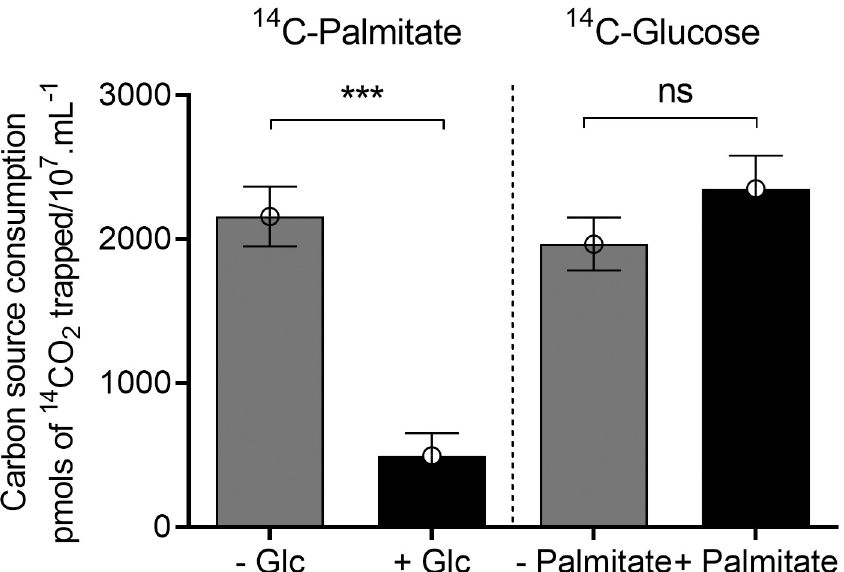
Fig 4. Glucose metabolism inhibits FAO. Parasites were incubated in the presence of 14 C-U-palmitate + 5 mM glucose and 14 C-U-glucose + 0.1 mM palmitate in PBS. 14 CO 2 production from epimastigotes incubated in PBS. The 14 CO 2 was captured after 120 min of incubation. The experiments were performed in triplicates. Statistical analysis was performed with one-way ANOVA followed by Tukey’s post-test p < 0.05 using the GraphPad Prism 8.0.2 software program. We represent the level of statistical significance in this figure as follows: ��� p value < 0.001; �� p value < 0.01; and � p value < 0.05. For p value > 0.05, we consider the differences not significant